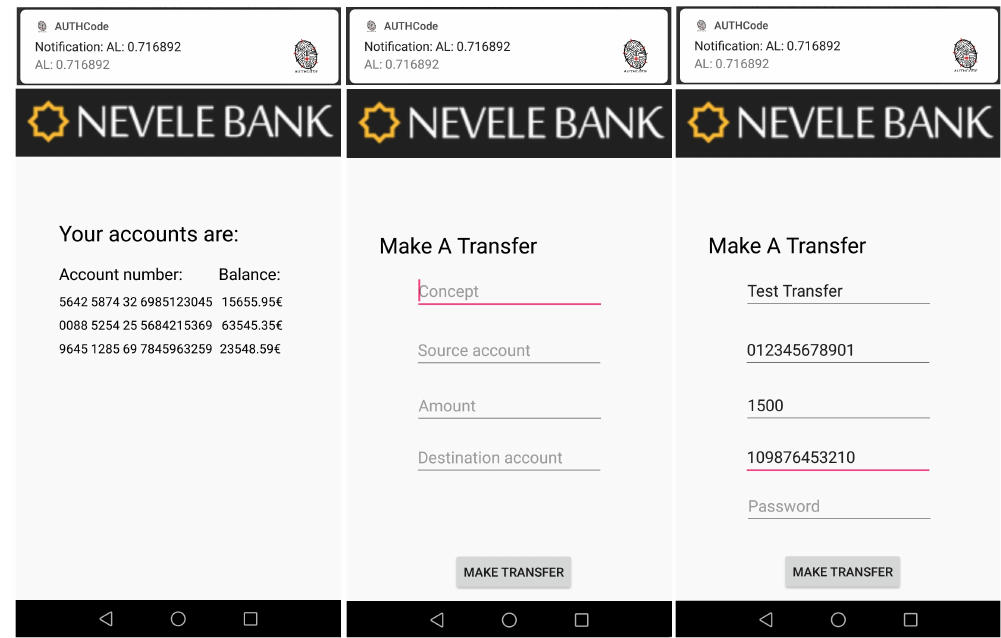
Figure 13. UserA using the online banking application after UserB.